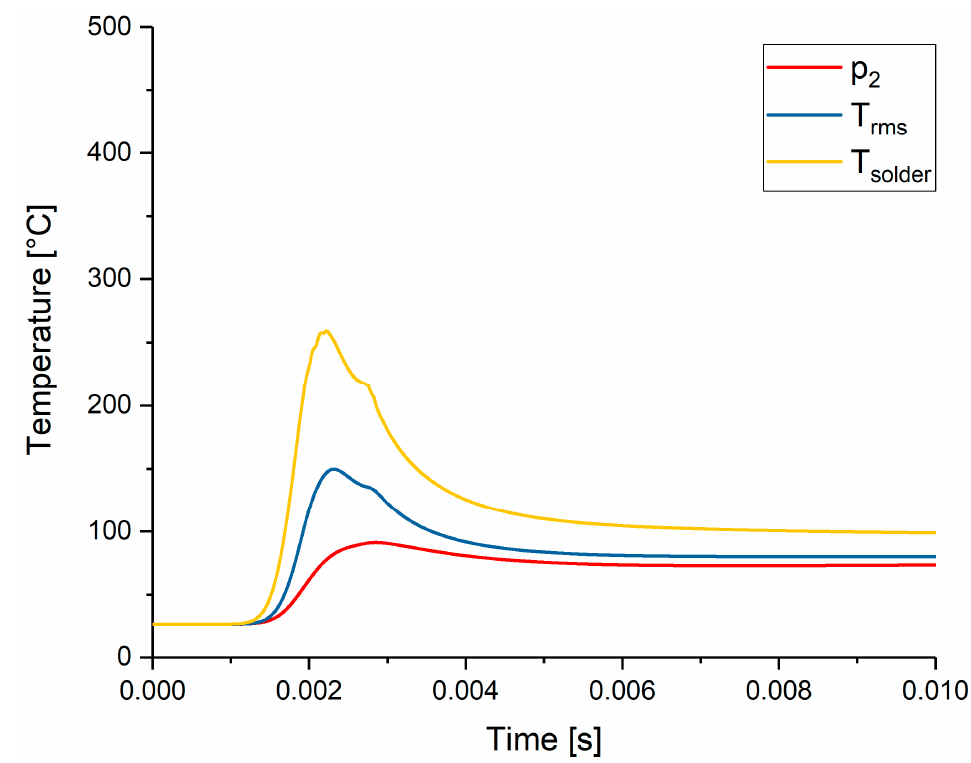
Figure 17. Time–temperature history for three locations, the probe p 2 , T rms and T solder.